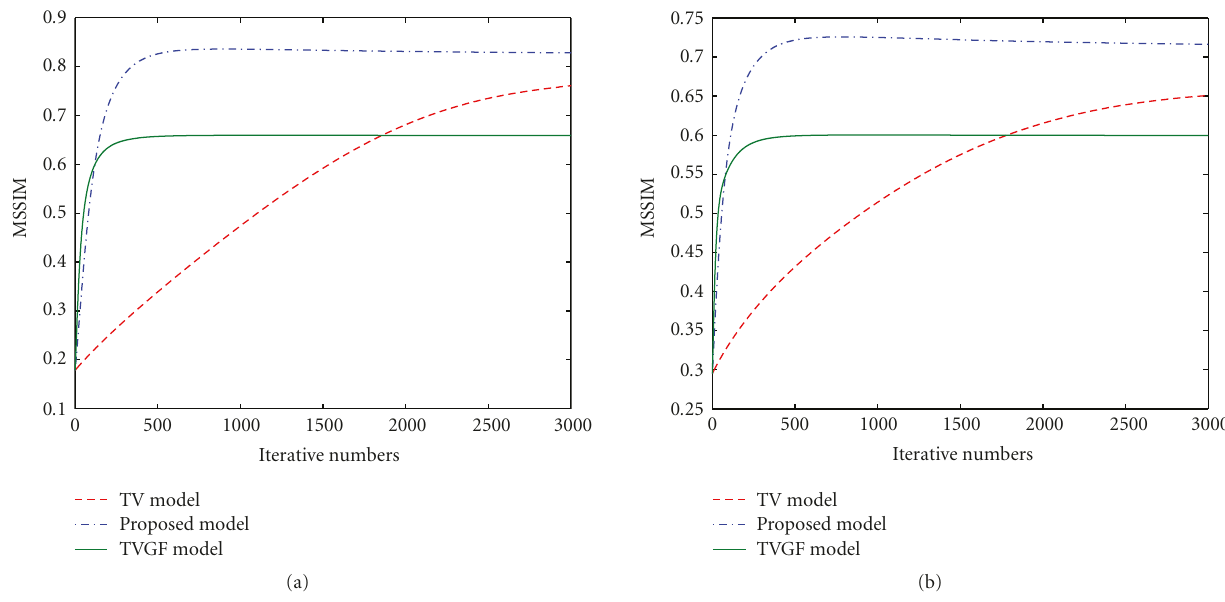
Figure 18: Comparison of the MSSIM results of the di ff erent images which is corrupted by some Gaussian noise of standard deviation 35: (a) “Lena”; (b)